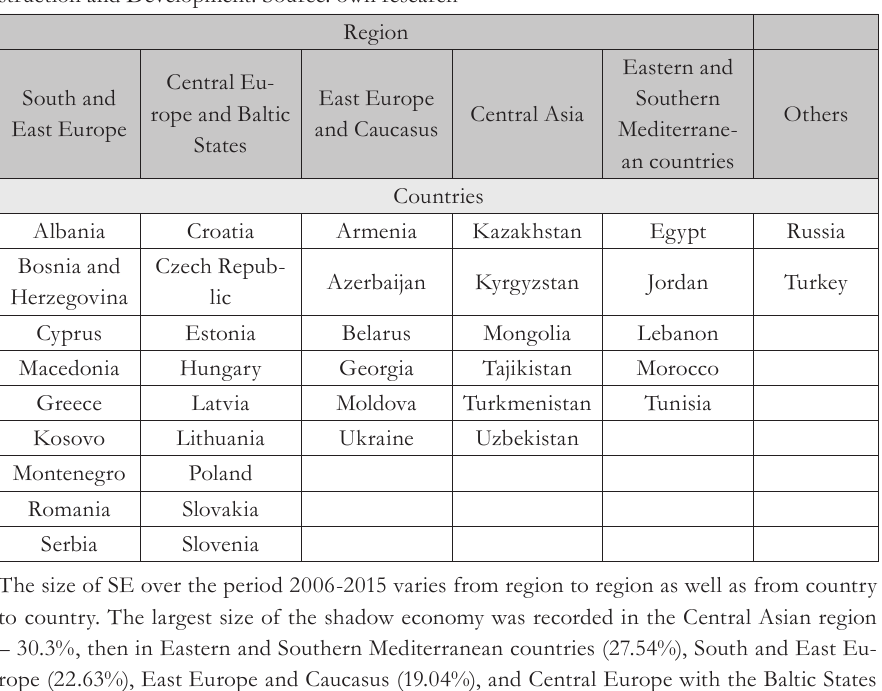
Tab. 3 – Categorization of countries by regions provided by the European Bank for Recon- struction and Development. Source: own